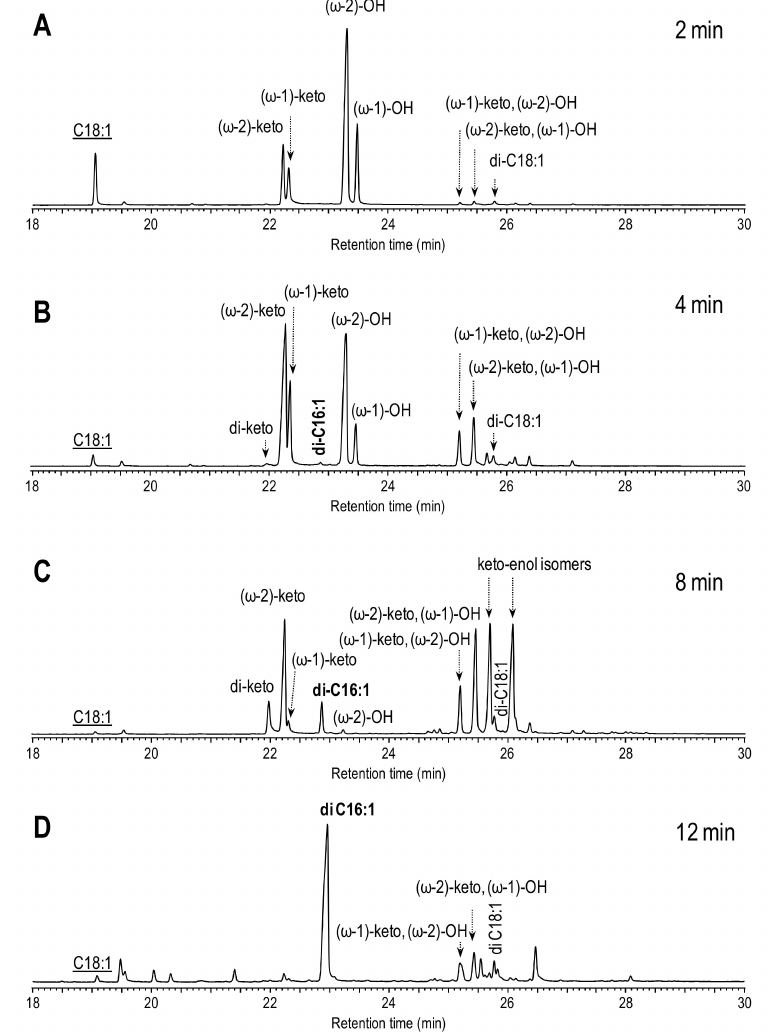
Figure 2. GC-MS evaluation of a time-course experiment with 0.2 µ M r Cci UPO and 0.1 mM oleic acid (underlined), within 2 min (0.5 mM H 2 O 2 ) ( A ), 4 min (1 mM H 2 O 2 ) ( B ), 8 min (2 mM H 2 O 2 ) ( C ) and 12 min (3 mM H 2 O 2 ) ( D ), showing the dicarboxylic acids (in bold), together with the hydroxy, with minor keto, enol and epoxide derivatives. The chemical structures of oleic acid and their derivatives are depicted in Figure